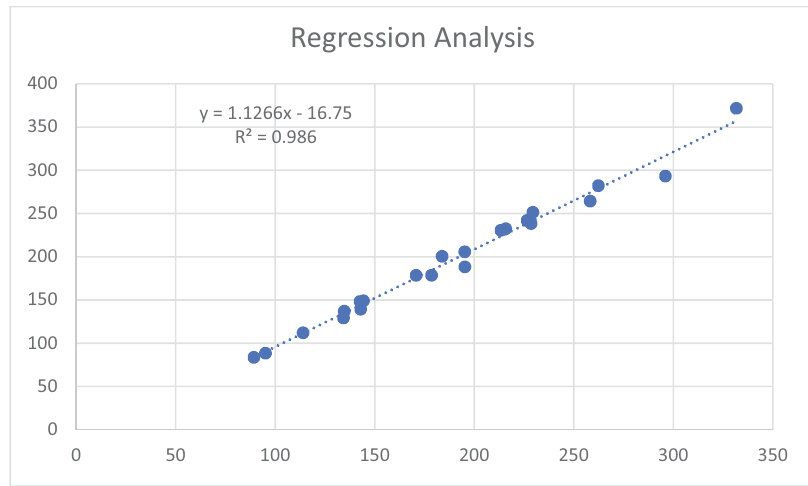
Figure 5: Regression analysis of the ANN model with six neurons in its hidden